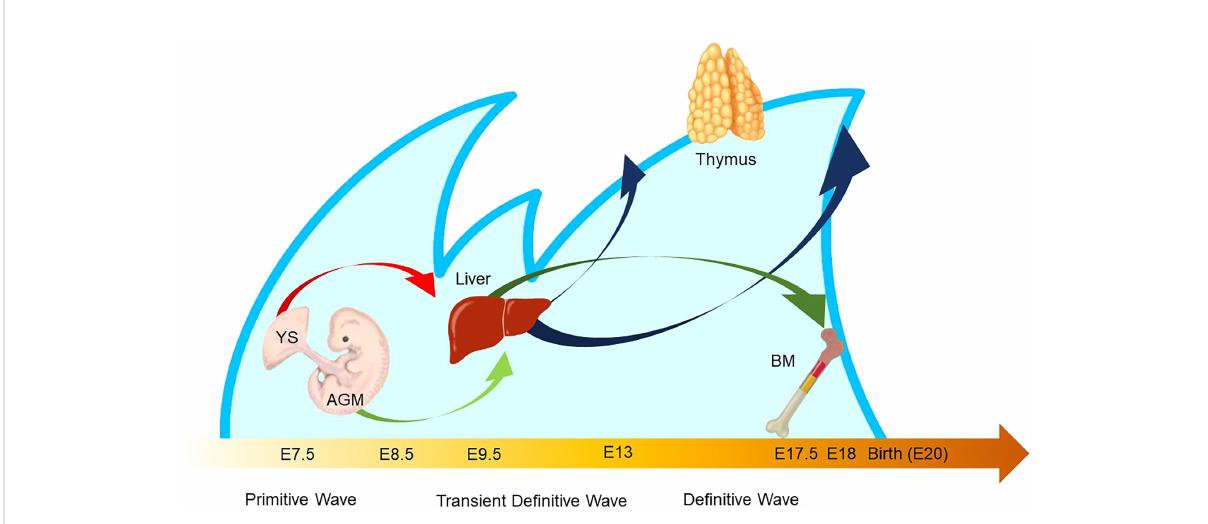
FIGURE 5 Waves of layered immunity during embryonic development in a mouse model. The blue waves indicate primitive, transient de fi nitive, and de fi nitive waves which start at E 7.5, E8.25, and E8.5, respectively. The blood islands in the yolk sac (YS) and aorta – gonad – mesonephros (AGM) independently give rise to their own hematopoietic progenitor cells. After the establishment of blood circulation, hematopoietic progenitors appear in the fetal liver at E 9.5. Then, the fetal liver turns into the main site for fetal hematopoiesis. Next, the waves of early thymic progenitors (ETPs) reach the thymus at E13 and E18. Subsequently, the hematopoietic progenitor cells are seeded into the bone marrow at